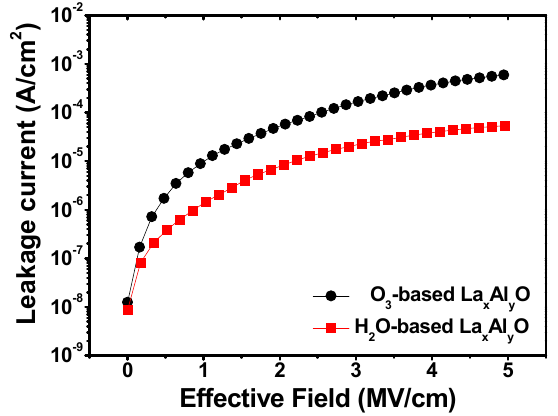
Figure 7. J - V characteristics of MIS capacitors using 5 nm O 3 -based and H 2 O-based La x Al y O films as insulators. as